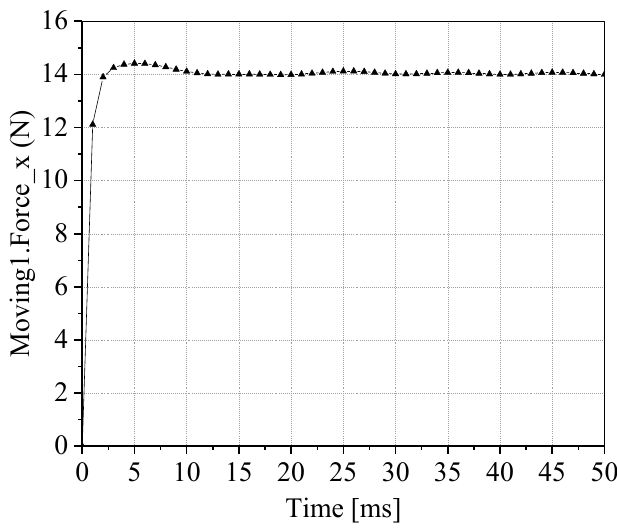
Figure 8. The electromagnetic thrust generated by the double ‐ sided model .